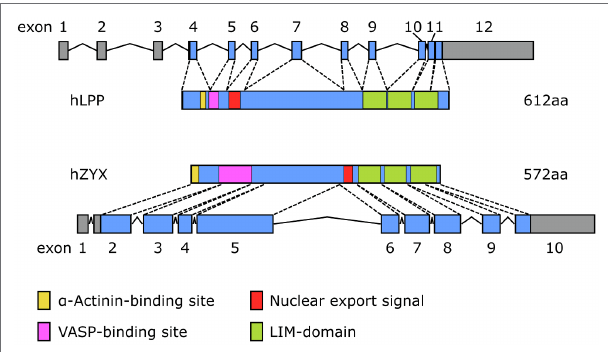
FIGURE 5 | Comparison of the exon-intron structure of the primary transcripts (hnRNA) of the human (top) LPP and (bottom) ZYX gene and their corresponding protein products (hLPP, hZYX). The color coding for the functional elements in both proteins corresponds to that of Figure 2